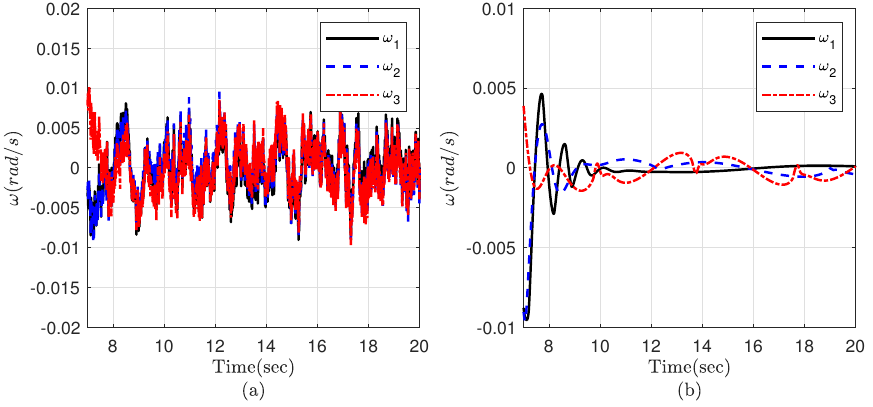
Figure 18. The rotation velocity in Part 3 in steady state: ( a ) noisy measurement, ( b ) high-frequency disturbance.